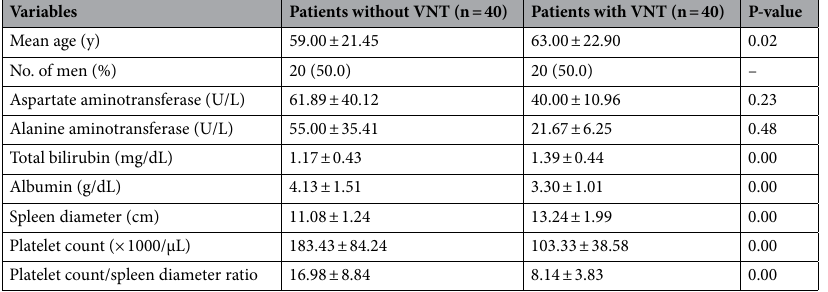
Table 1. Characteristics of cirrhotic patients with and without esophageal varices needing treatment (VNT). Independent two-sample t -test was used for statistical analysis.